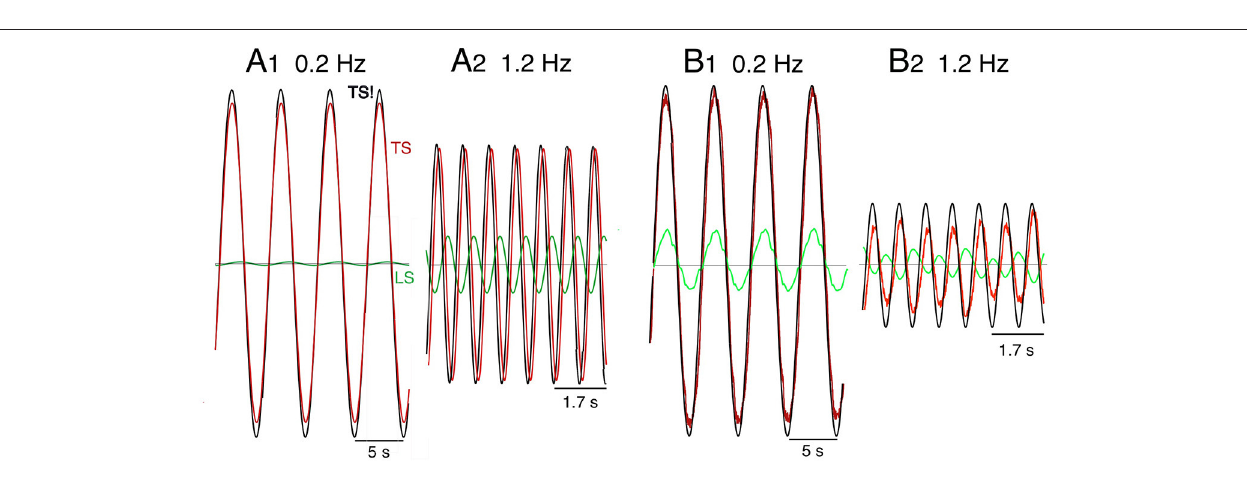
FIGURE 7 | Model simulation (A) and robot experiments (B) of internally generated (“voluntary”) sinusoidal rotations of desired trunk-space angle (TS!). Dynamic effects on leg-in-space (LS) would ideally be absent (see text). Note that the support surface is here not rotating, so that desired ankle angle q d 1 is equal to leg in space, LS, while q d 2 = TS ! − LS ! (i.e., using a notation that is more intuitive in the